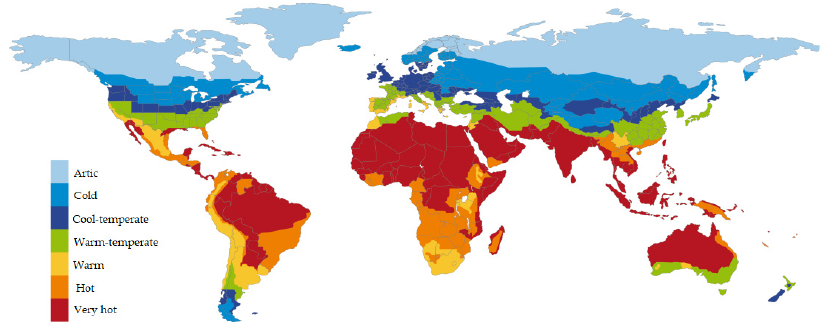
Figure 2. Passive House Institute climate zone map [18].